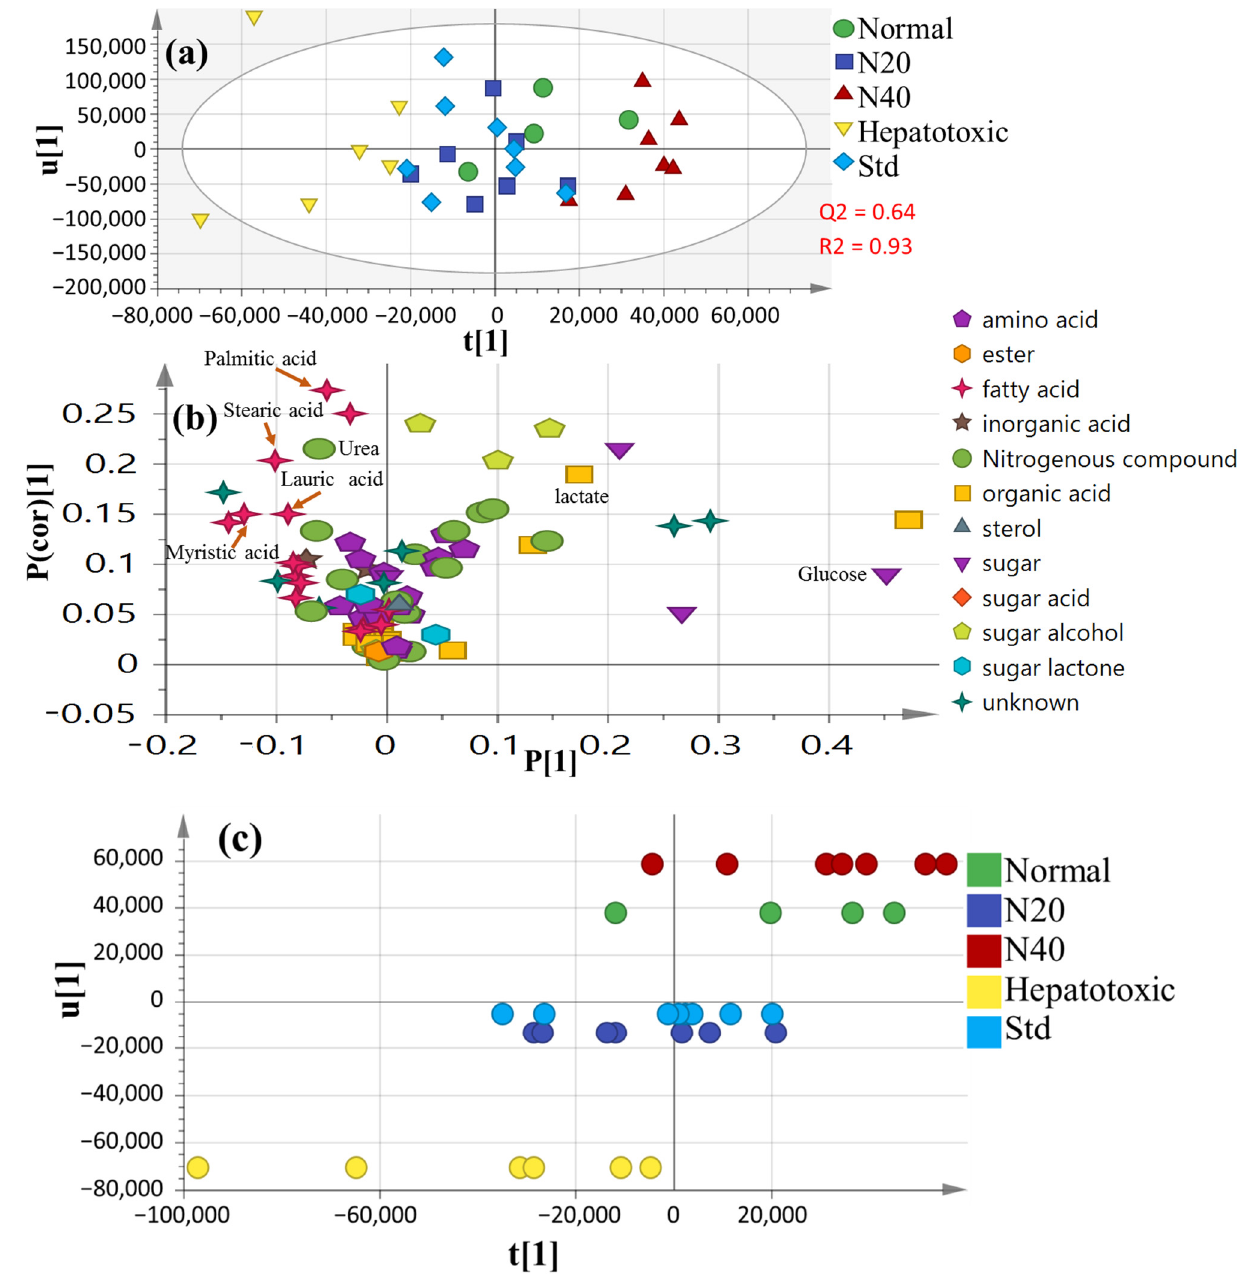
Figure 5. Supervised OPLS dataset for all groups ( n = 6): ( a ) OPLS-DA score plot; ( b ) The corre- sponding loading plot demonstrating the covariance P(1) versus the correlation P(cor)(1); ( c ) OPLS class inner relation with 40 mg naringenin (colored in red), showing a close relation to the normal untreated group (colored in green). N20: naringenin at 20 mg/kg; N40: naringenin at 40 mg/kg; Std: standard drug (silymarin).